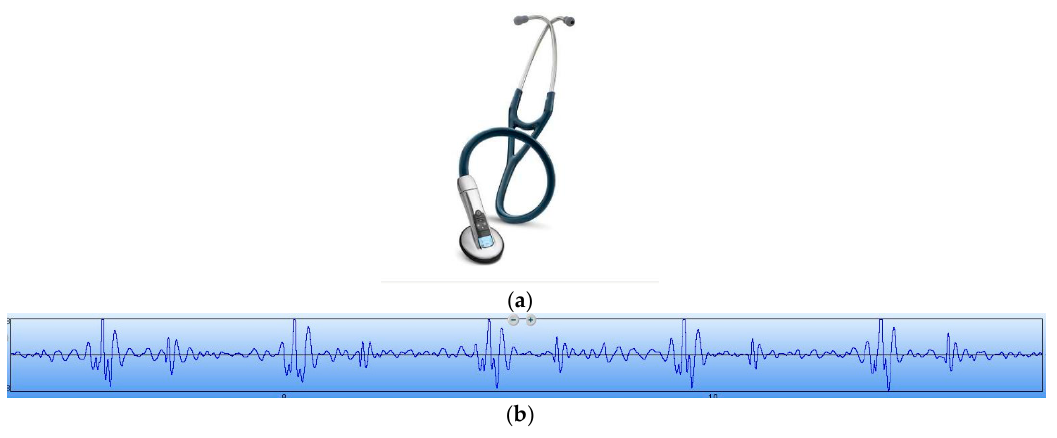
Figure 14. A 3200-type electronic stethoscope and its test results. ( a ) A 3200-type electronic stethoscope; and ( b ) the waveform tested by the 3200-type electronic stethoscope.